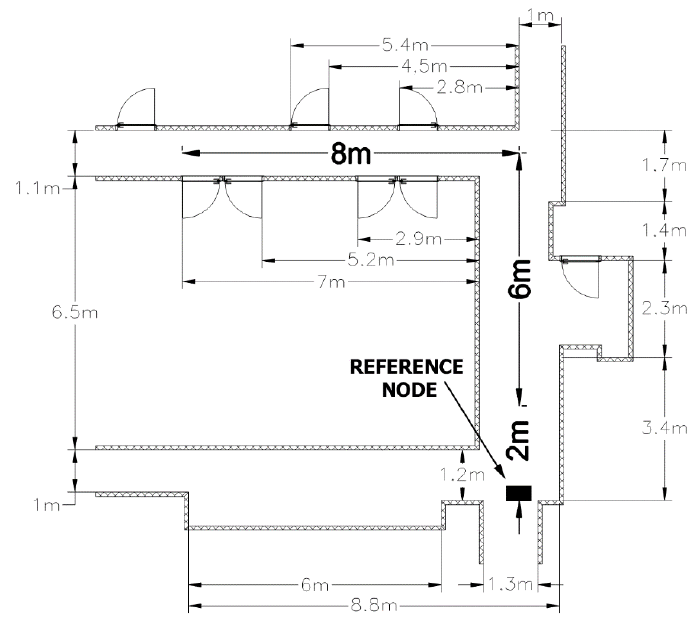
Figure 3. A plan of the investigated scenario—part of the passenger ferryboat’s seventh deck.